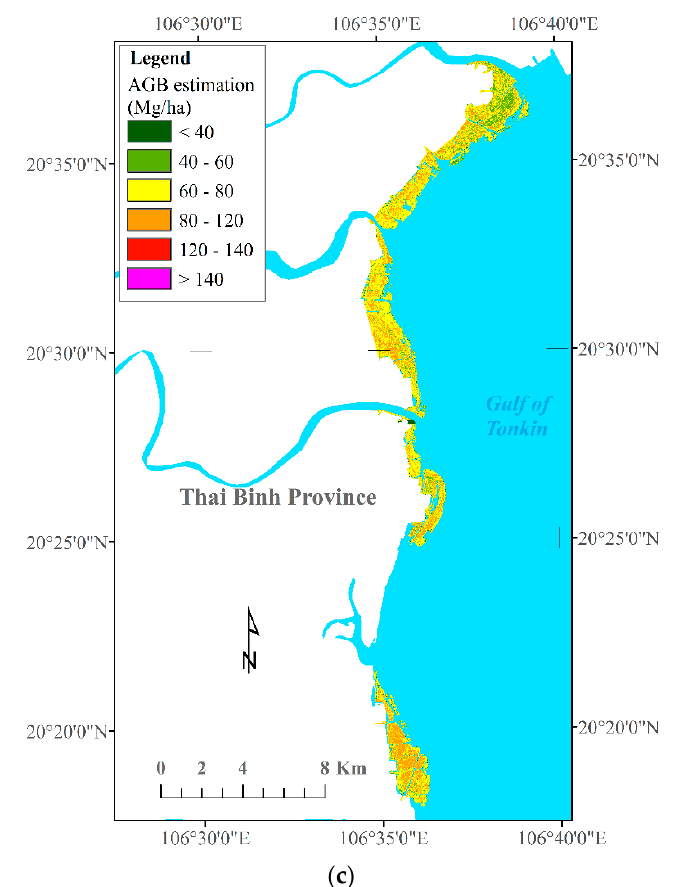
Figure 6. Mangrove AGB estimation maps across the three studied coastal areas in the RRDBR. ( a ) Nam Dinh—Ramsar site, ( b ) Hai Phong, ( c ) Thai Binh.